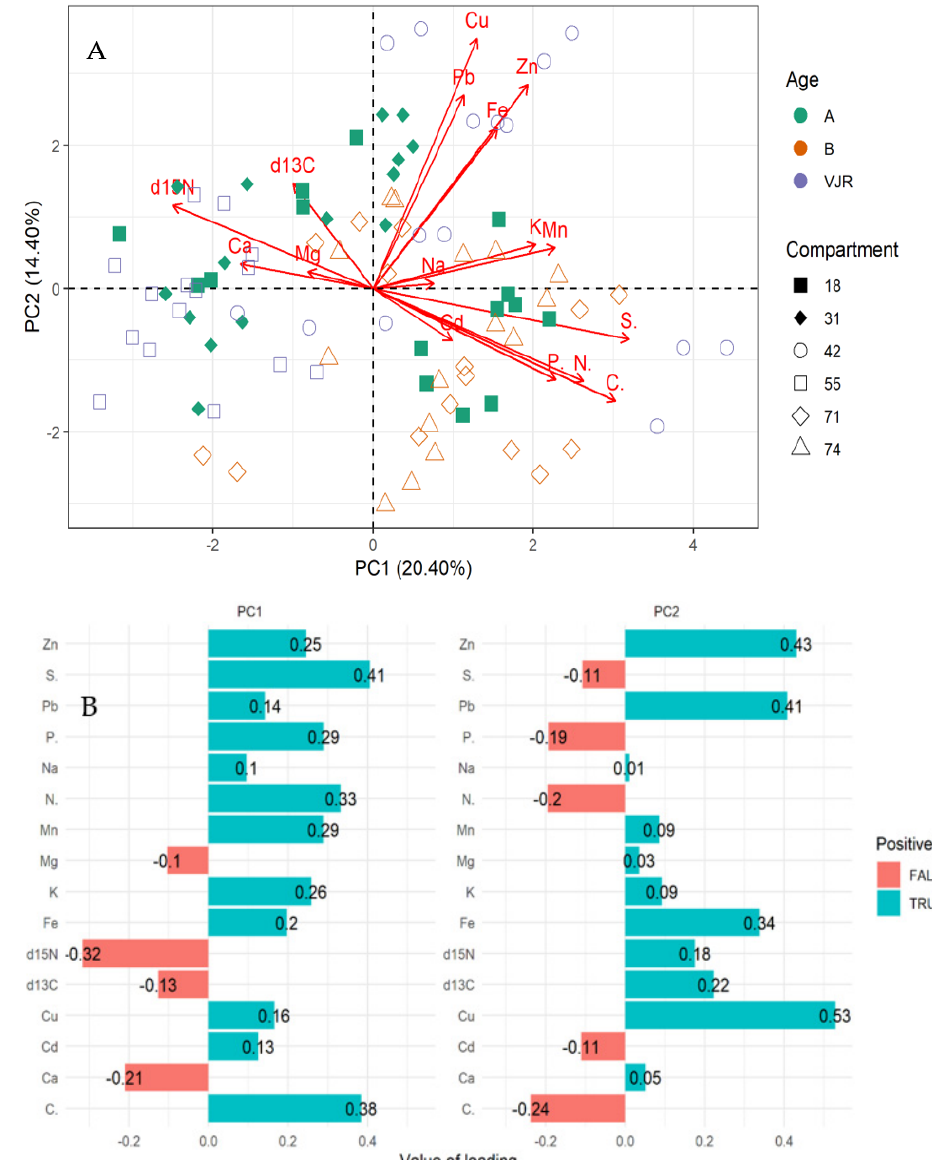
Figure 3. Relationship between elements in sediment, compartments, and compartment ages in the Matang Mangrove Forest Reserve as determined by principal component analysis biplot ( A ) and loadings ( B ).